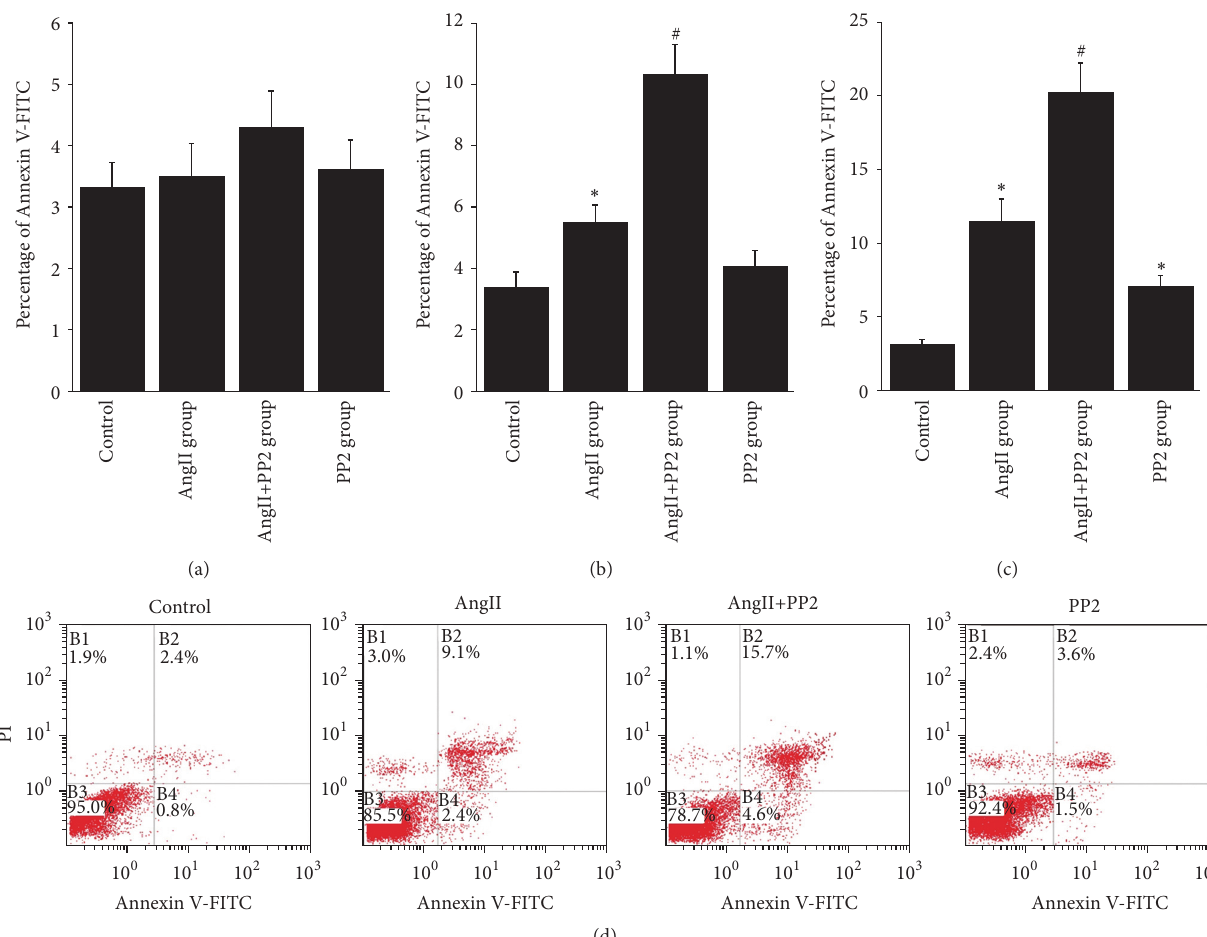
Figure 4: Determination of PMVECs apoptosis by flow cytometry. No obvious apoptosis was noticed in the PMVECs within 3 hours (a) after AngII stimulation. Apoptotic changes were noticed in the PMVECs within 12 h (b) to 24h (c), which was obviously elevated after PP2 stimulation. (d) Obvious apoptotic changes were noticed in PMVECs within 24 h after AngII stimulation. ∗ 𝑃 < 0.05 versus control group; # 𝑃 < 0.05 versus AngII